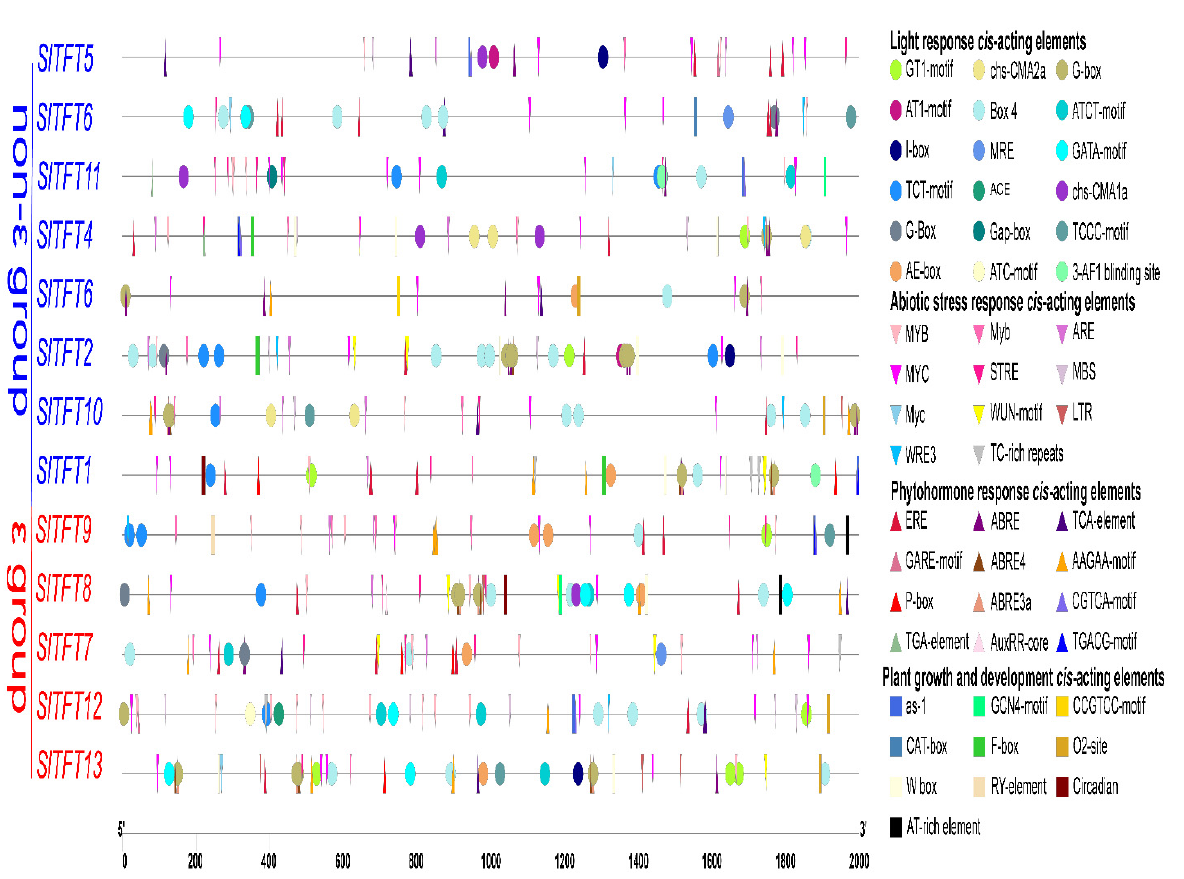
Figure 6. Predicted cis -acting elements in the promoter regions of SlTFTs . Gene names are arranged according to the order of the phylogenetic tree. The different color fonts on the left side are the grouping of SlTFTs and the corresponding members. The thin gray line in the middle represents sequences within 2000 bp upstream of the initiation codon of each SlTFTs , and the scale of base lengths at the bottom, where different colors and shapes of patterns represent different classes of cis -acting elements. A detailed division of the four major categories of cis -acting elements is provided on the right.